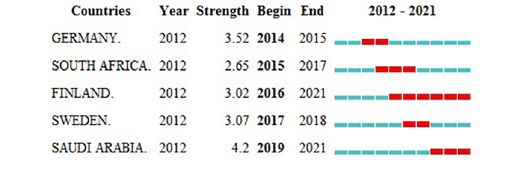
FIGURE3 Top five countries with the strongest citation bursts (2012–2021). Burst refers to a sudden increase in the number of citations in a certain period, suggesting an increased research intensity in that country. The red bands indicate the duration of